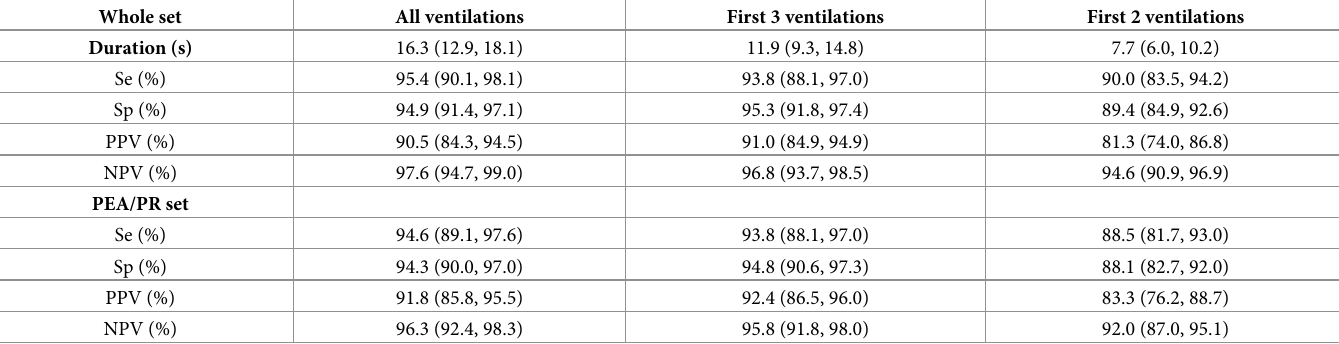
Table 2. ROSC detection results, as a function of the number of considered ventilations per segment, for the whole set and for the PEA/PR subset. Durations are reported as median (IQR). The 95% confidence intervals are in parenthesis. Whole